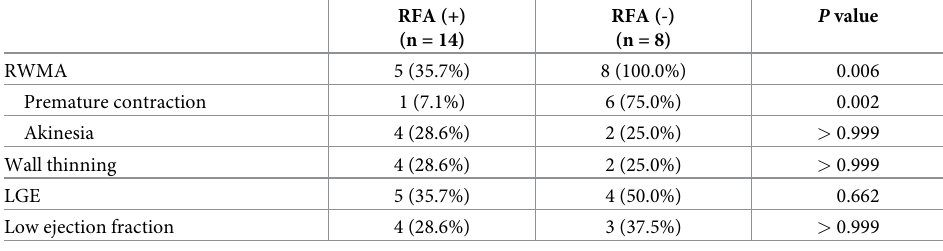
Table 3. Comparison of major findings according to performance of RFA.